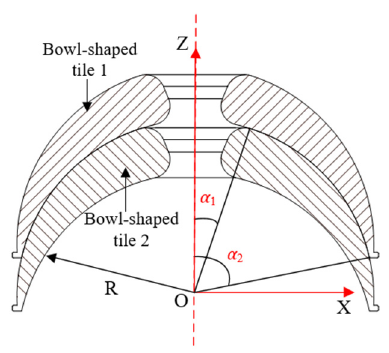
Figure 4. Illustration of the contact between two bowl-shaped tiles.